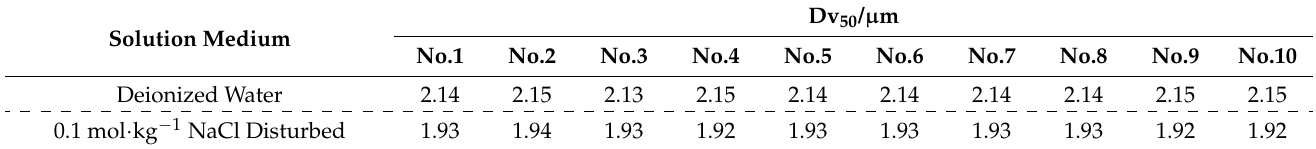
Table 2. IREO colloid particle size test results in deionized aqueous solution before and after NaCl concentration